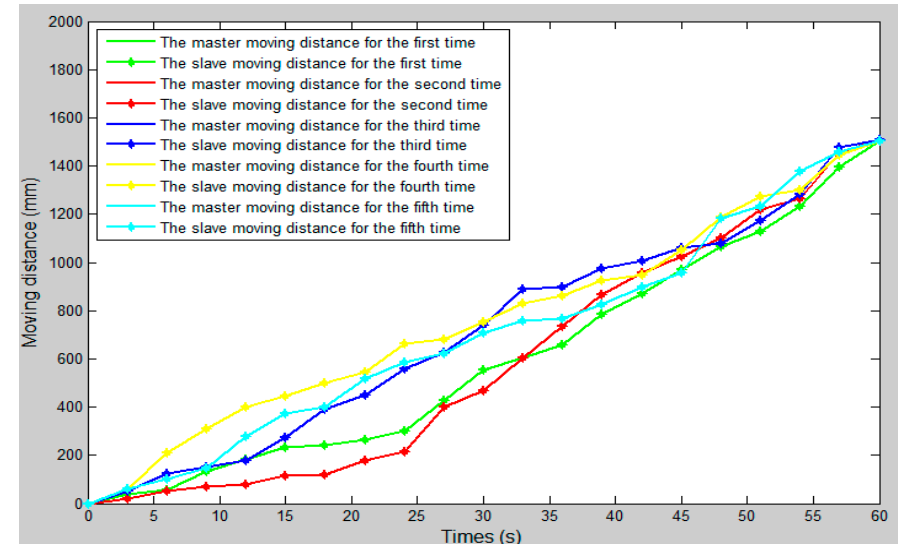
Figure 15. The comparison curve between the slave moving distance and the master moving distance.